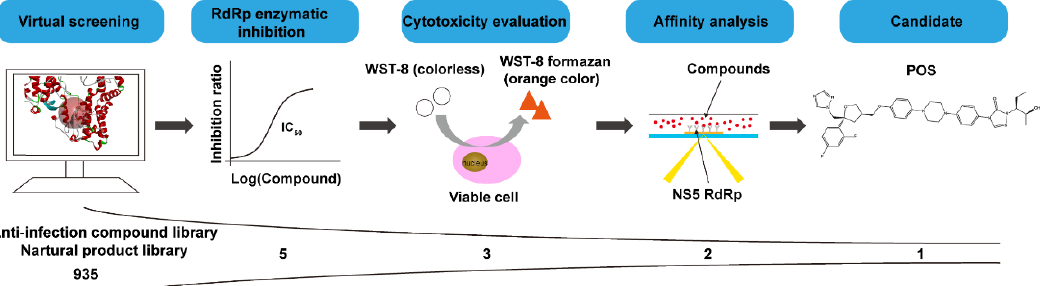
Figure 1. Flow chart depicting the methodology used in the screening of ZIKV NS5 RdRp inhibitors. 935 compounds from an anti-infection compound library and a natural product library were applied to the virtual screening by Discovery Studio in LibDock program. Five compounds, with the top LibDock scores, were chosen to determine the inhibitory effects on RdRp. Three compounds, which had higher inhibitory effects on RdRp, were applied to the cytotoxicity analysis by WST-8. Excluding a compound that was toxic to cells, two compounds were chosen to examine the affinities with RdRp by SPR. At last, POS was selected as the candidate.